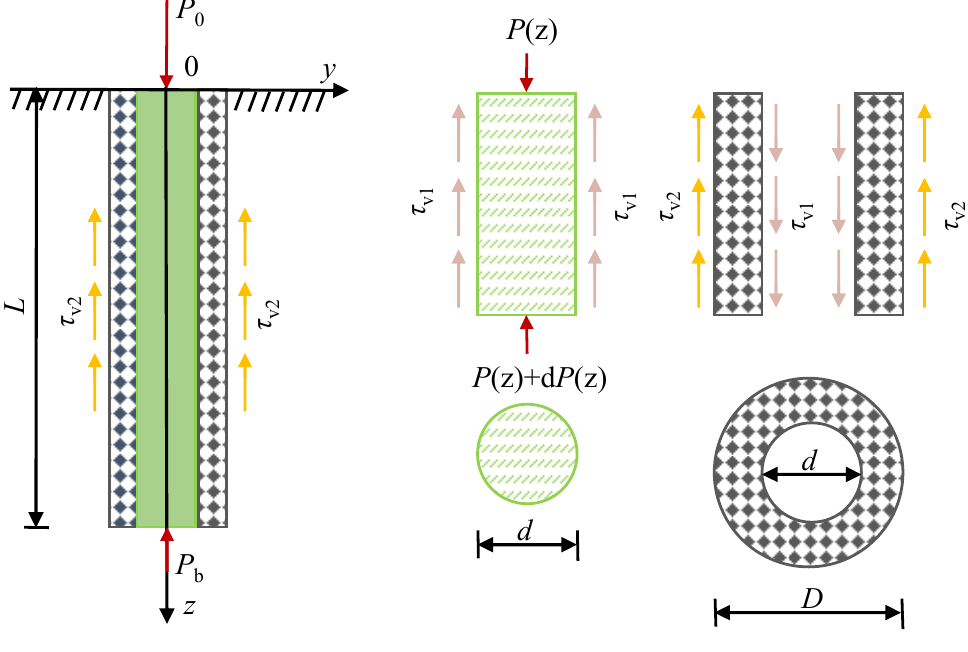
Figure 3. Force diagram of the SDM column under rigid loads [35].